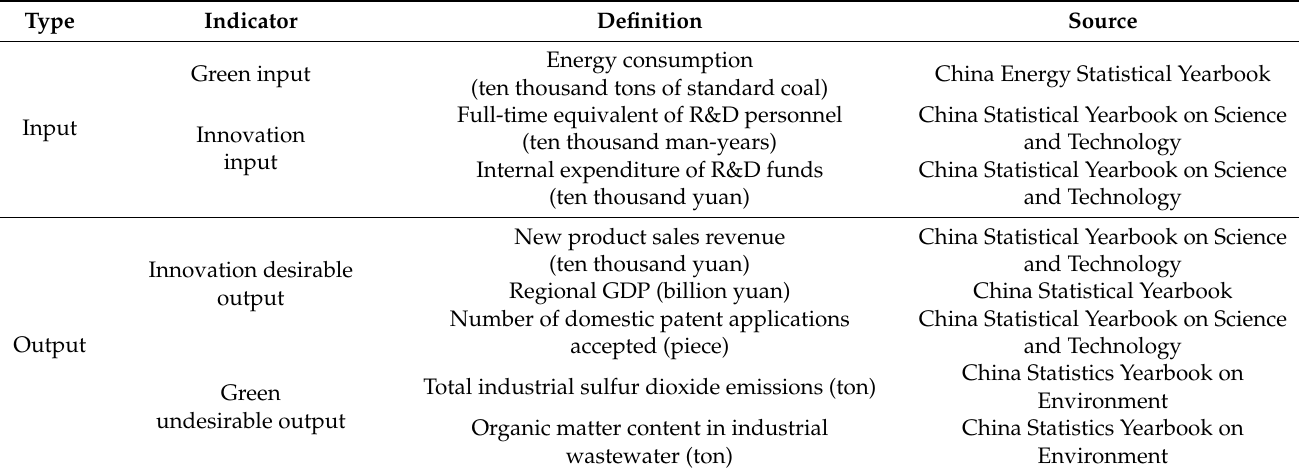
Table 2. Input-output system of green innovation